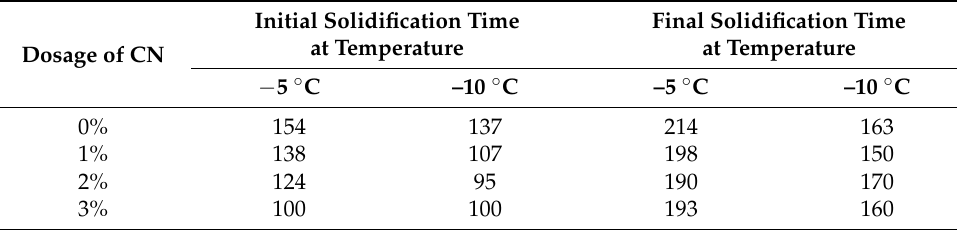
Table 5. Solidification time (min) at temperature − 5 ◦ C and − 10 ◦ C for CEM IIR paste.